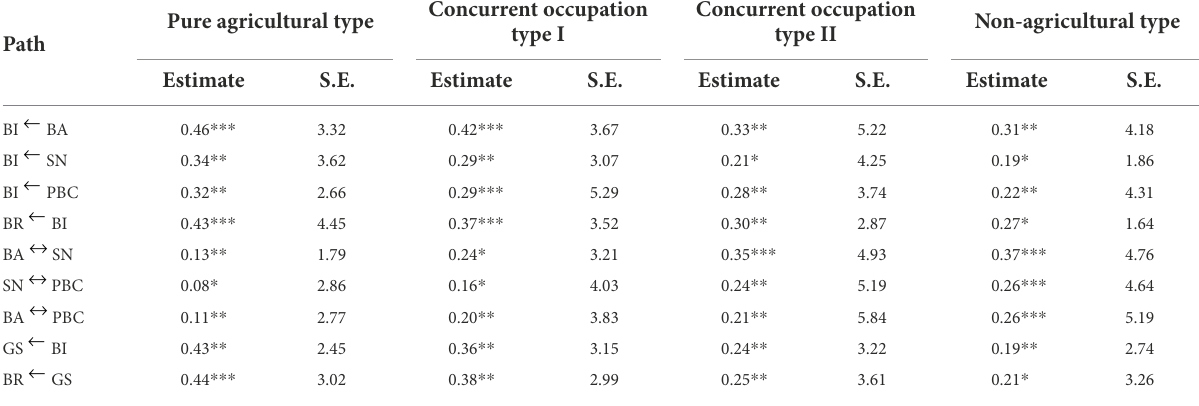
TABLE 6 Estimation results of multi-group model test.